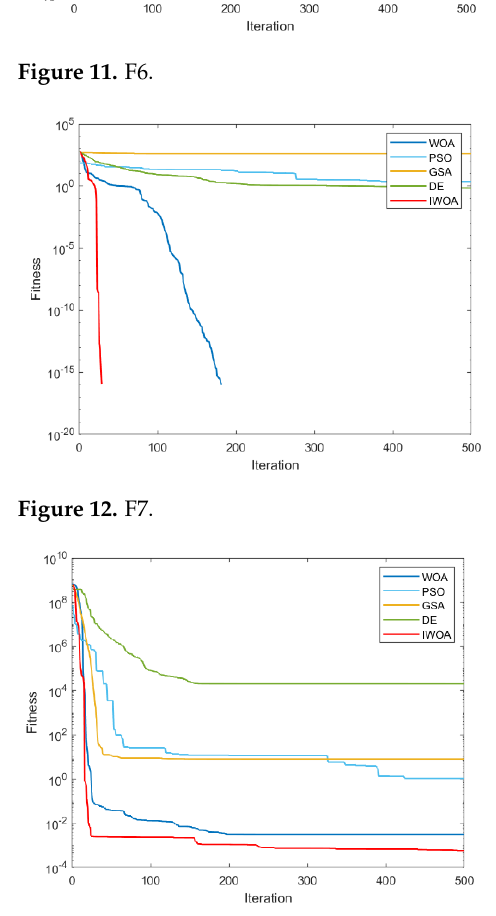
Figure 13. F8. Figure 13. Figure 13. F8.